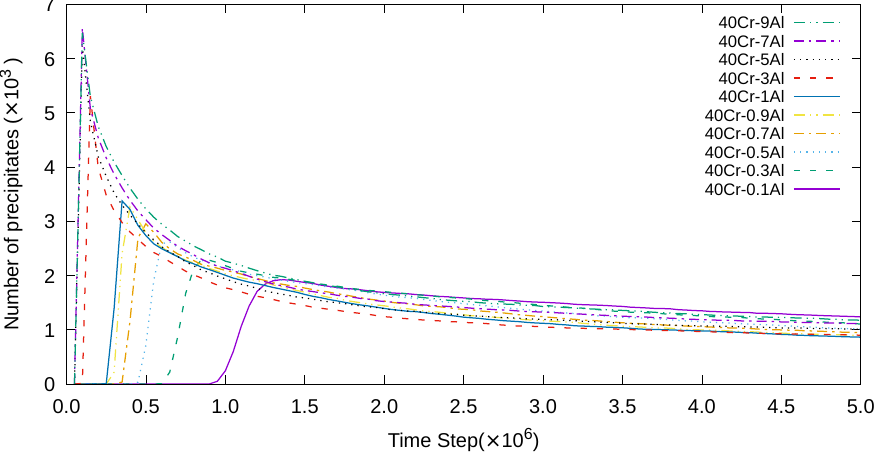
Figure 9. Number of α (cid:48) precipitates of the 2D simulation when the average Cr concentration was 40% at various average Al concentrations. A clear overshooting was observed before the t ∗ = 5.0 × 10 5 when the average Al concentration was above